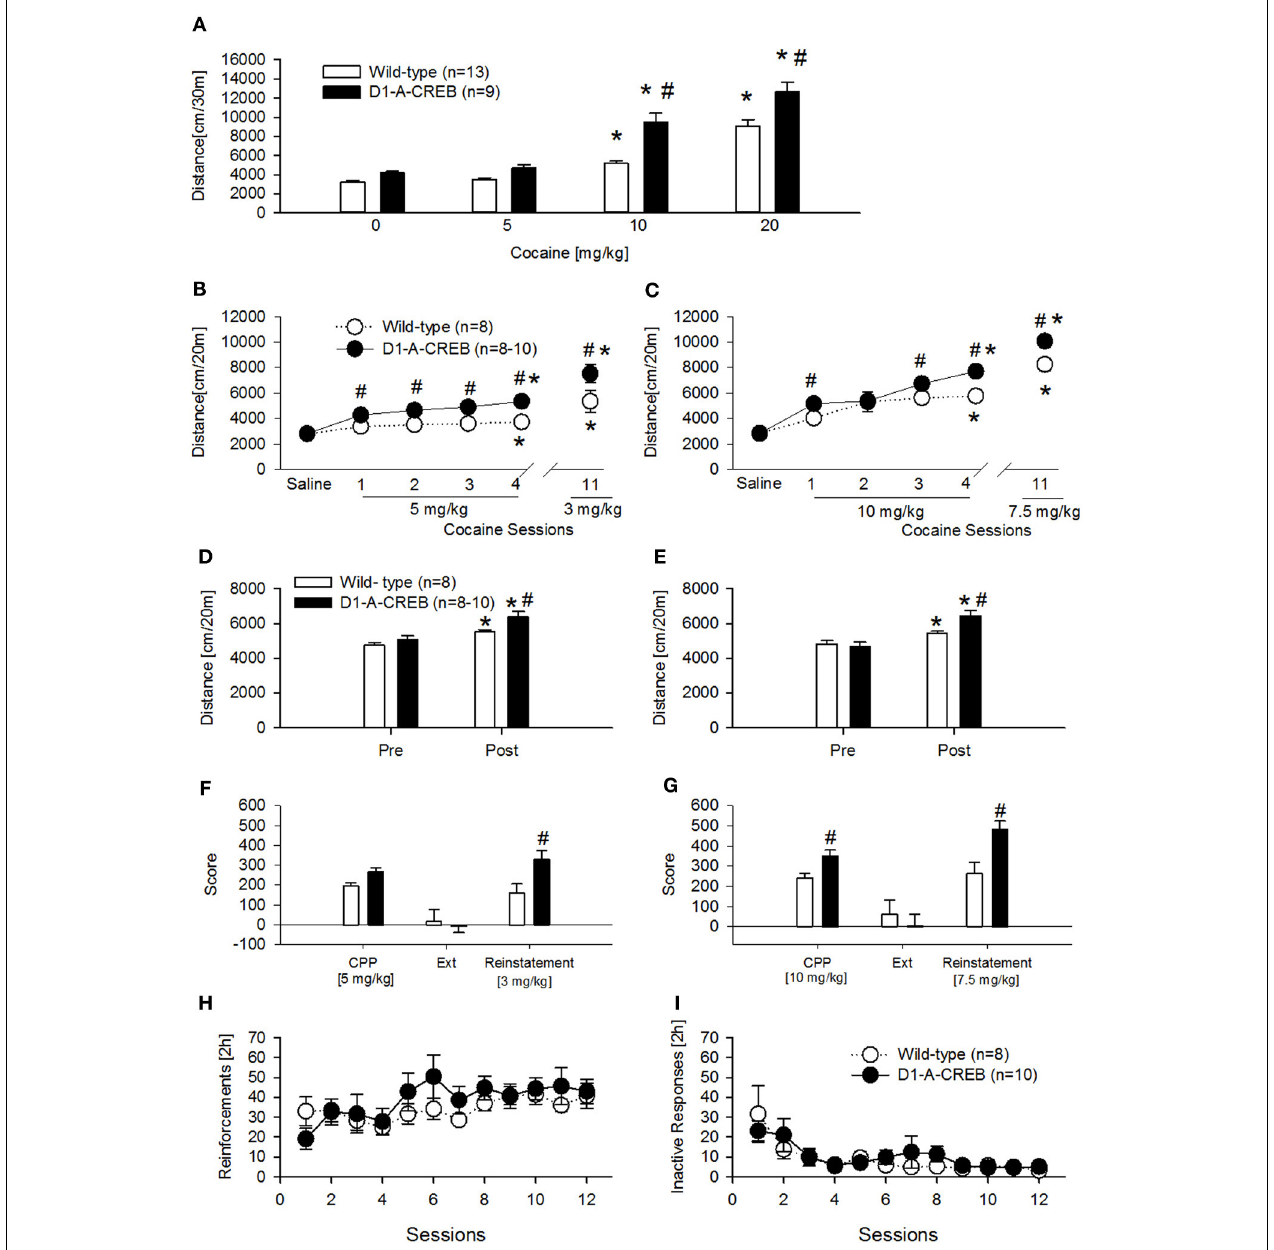
FIGURE 5 | Cocaine-induced behavioral effects in D1-A-CREB mice. (A) Cocaine induced a higher increase in locomotor activity in the activity box at doses of 10 and 20mg/kg cocaine in D1-A-CREB ( n = 9) mice compared with wild-type ( n = 13) mice. Two-Way ANOVA indicated a Genotype effect F (1 , 19) = 27 . 5, P < 0 . 001, a Dose effect F (3 , 57) = 132 . 3, P < 0 . 001, and a Genotype × Dose interaction F (3 , 57) = 4 . 3, P < 0 . 01. (B,C) Cocaine-induced development and expression of behavioral sensitization. At the dose of 5mg/kg (B) , wild-type and D1-A-CREB mice showed development of cocaine sensitization [ Sensitization effect F (5 , 70) = 29 . 9, P < 0 . 001], but D1-A-CREB mice expressed a significantly higher response to repeated cocaine injections and after a drug free interval (day 11) than the wild-type mice. Two-Way ANOVA indicated genotype [ F (1 , 14) = 21 . 9, P < 0 . 0005] and Genotype × Sensitization [ F (3 , 70) = 2 . 3, P < 0 . 05] effect. Similarly, at the dose of 10mg/kg (C) both development and the expression of behavioral sensitization